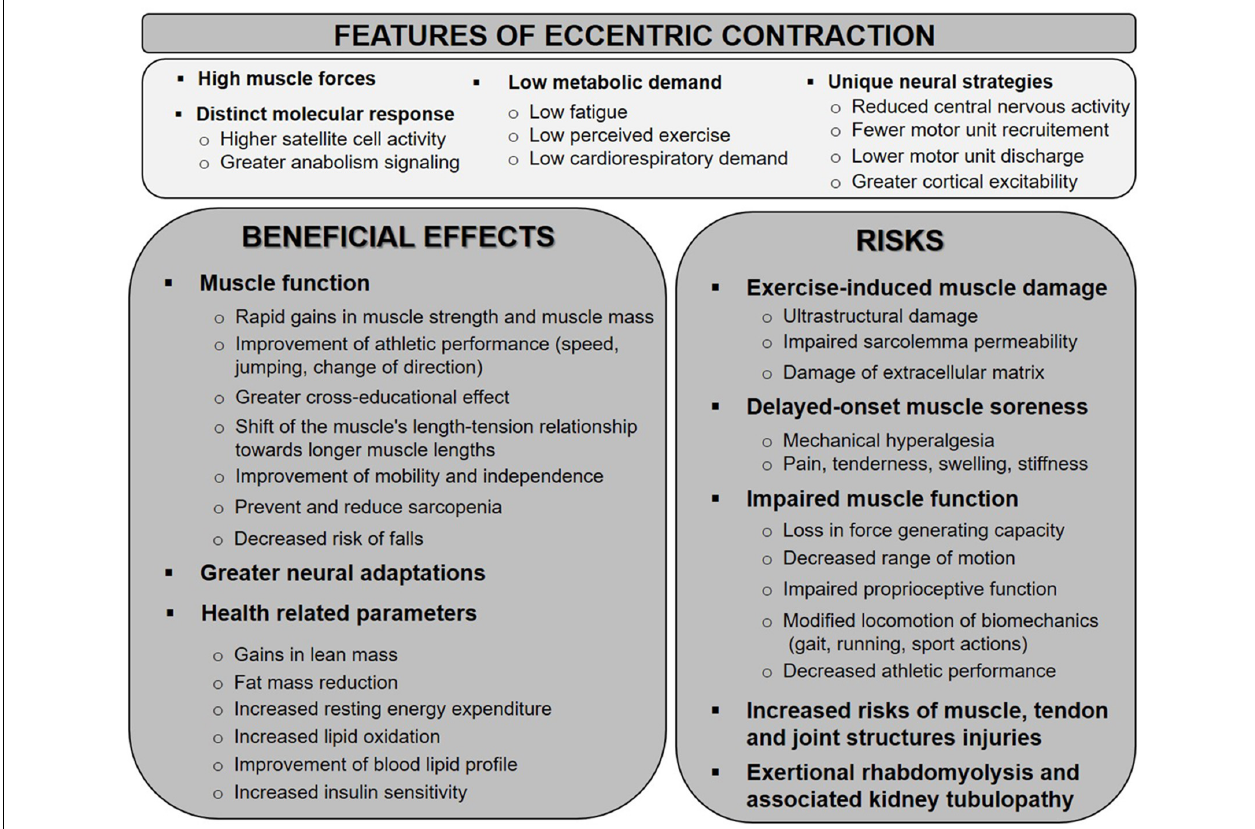
FIGURE 2 | Schematic representation of the potential mechanisms associated with eccentric exercise-induced muscle damage and involved in the development of DOMS. BD, bradykinin; CK, creatine kinase; DOMS, delayed-onset muscle soreness; E–C, excitation–contraction; GDNF, glial cell line-derived neurotrophic factor; IL, interleukin; NGF, nerve growth factor; ROS/RNS, reactive oxygen and nitrogen species; TNF, tumor necrosis factor.